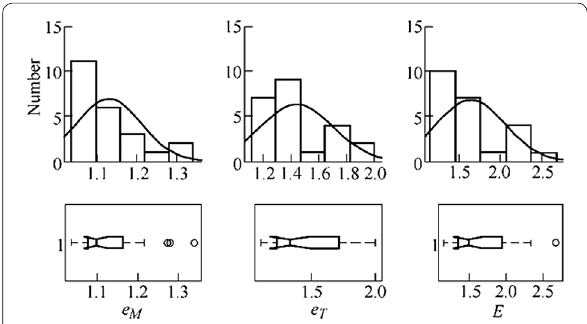
Figure 9 Histograms and box plots for LPG IV generation engine